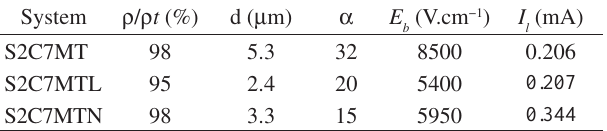
Figure 1. Microstructure of the varistor systems studied: a) S2C7MT; ) and current leakage b b) S2C7MTL; c) S2C7MTN.